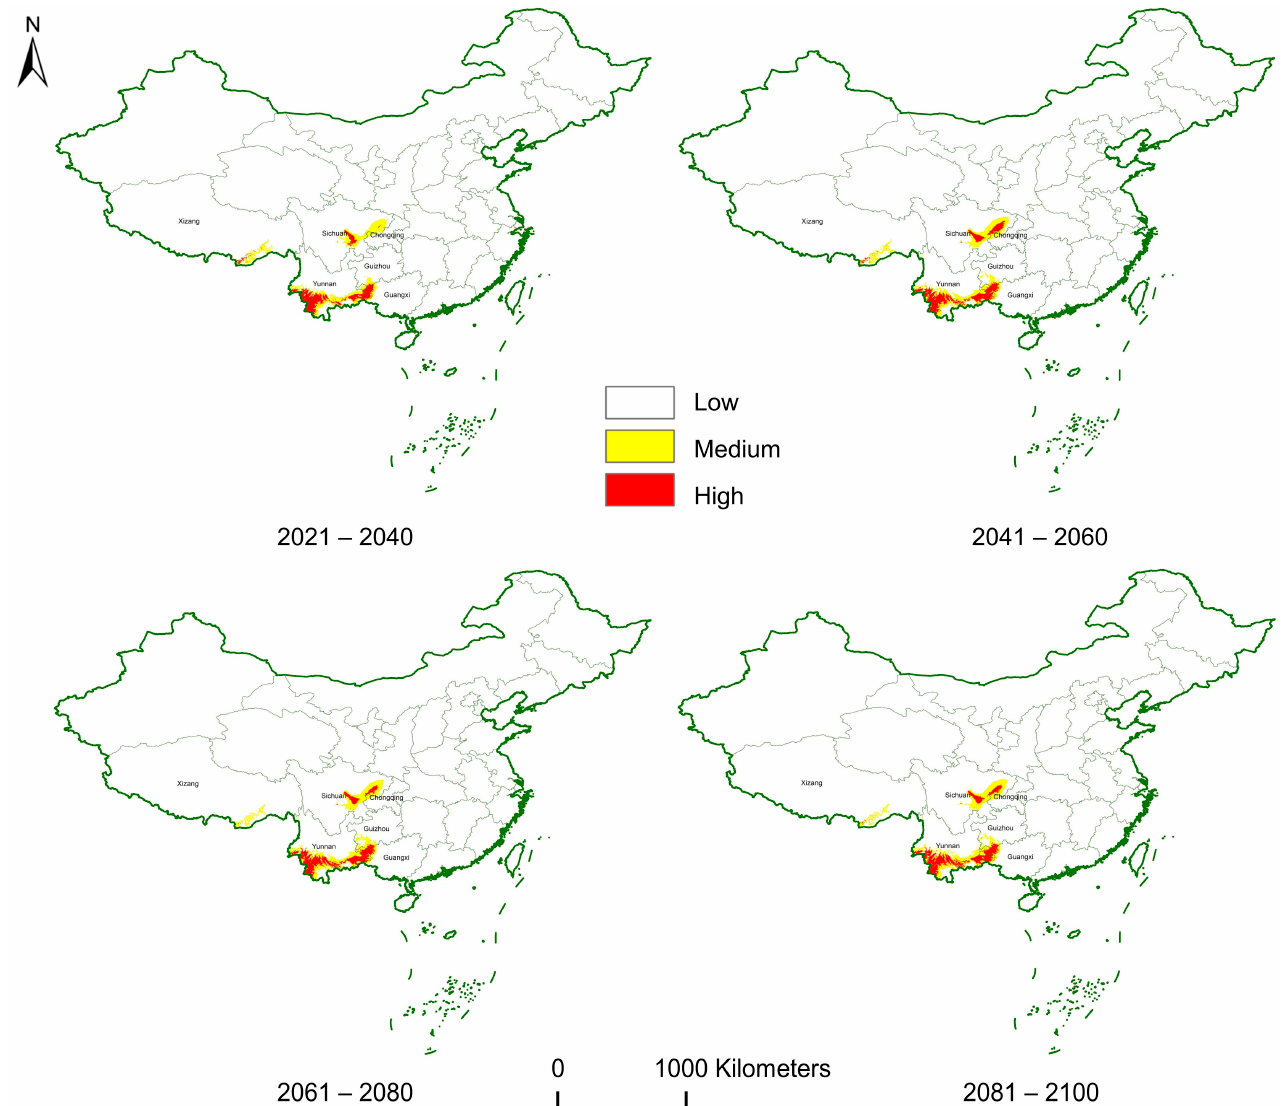
Figure 5. Potential niches of ancient Pu’er tea trees over the next 80 years in China. The classes indicate levels of environmental